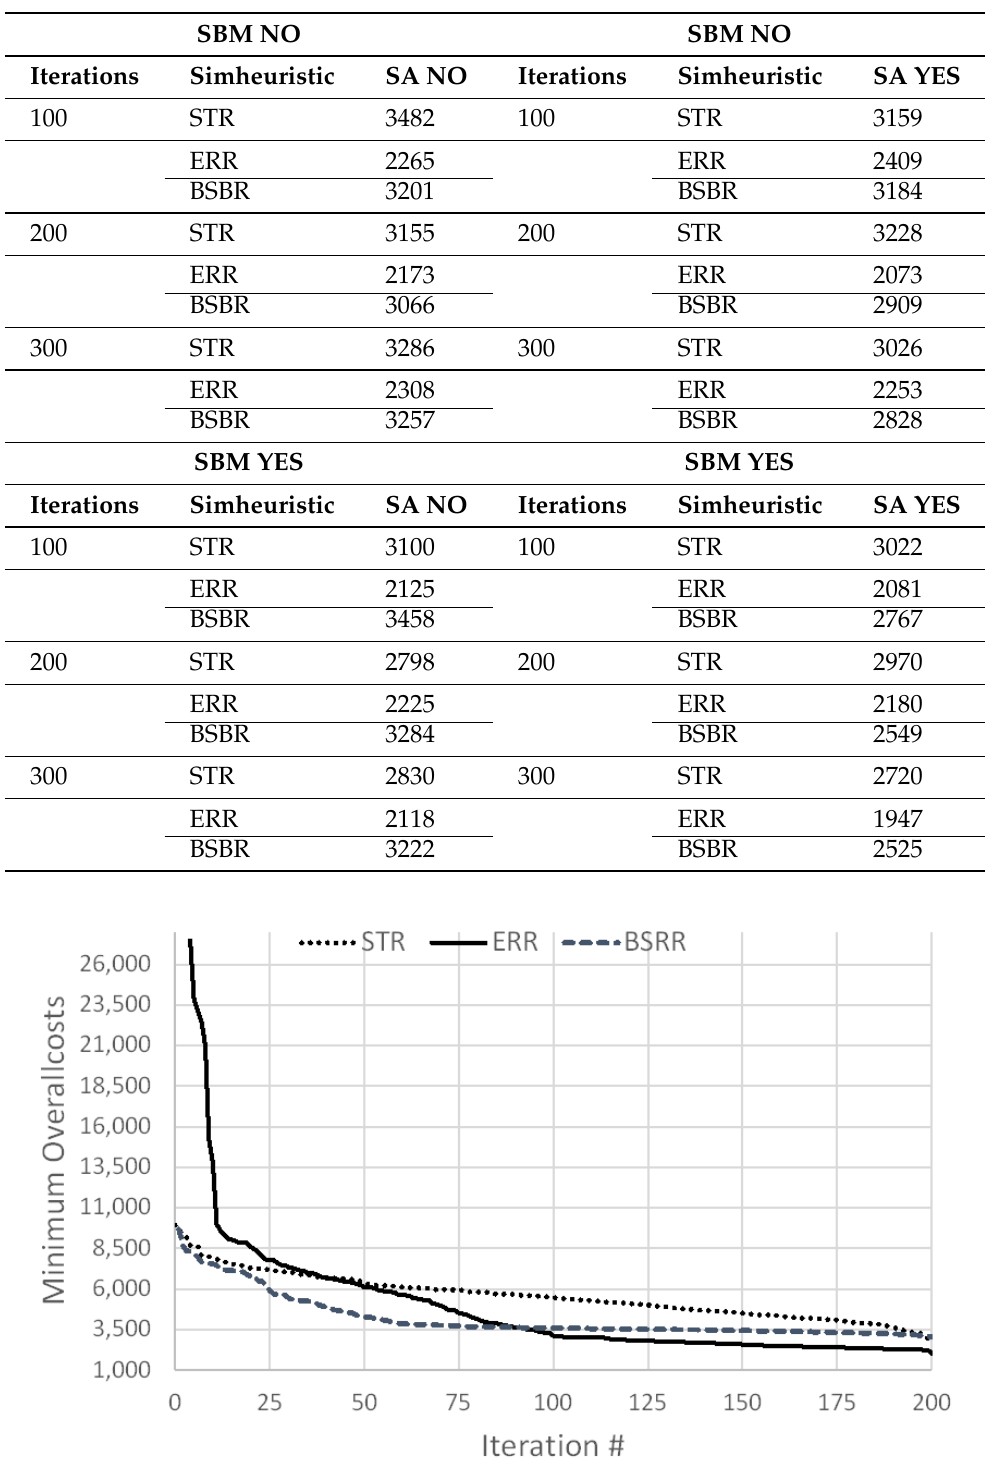
Table 4. Scenario comparison using minimum overall costs per simulation experiment.